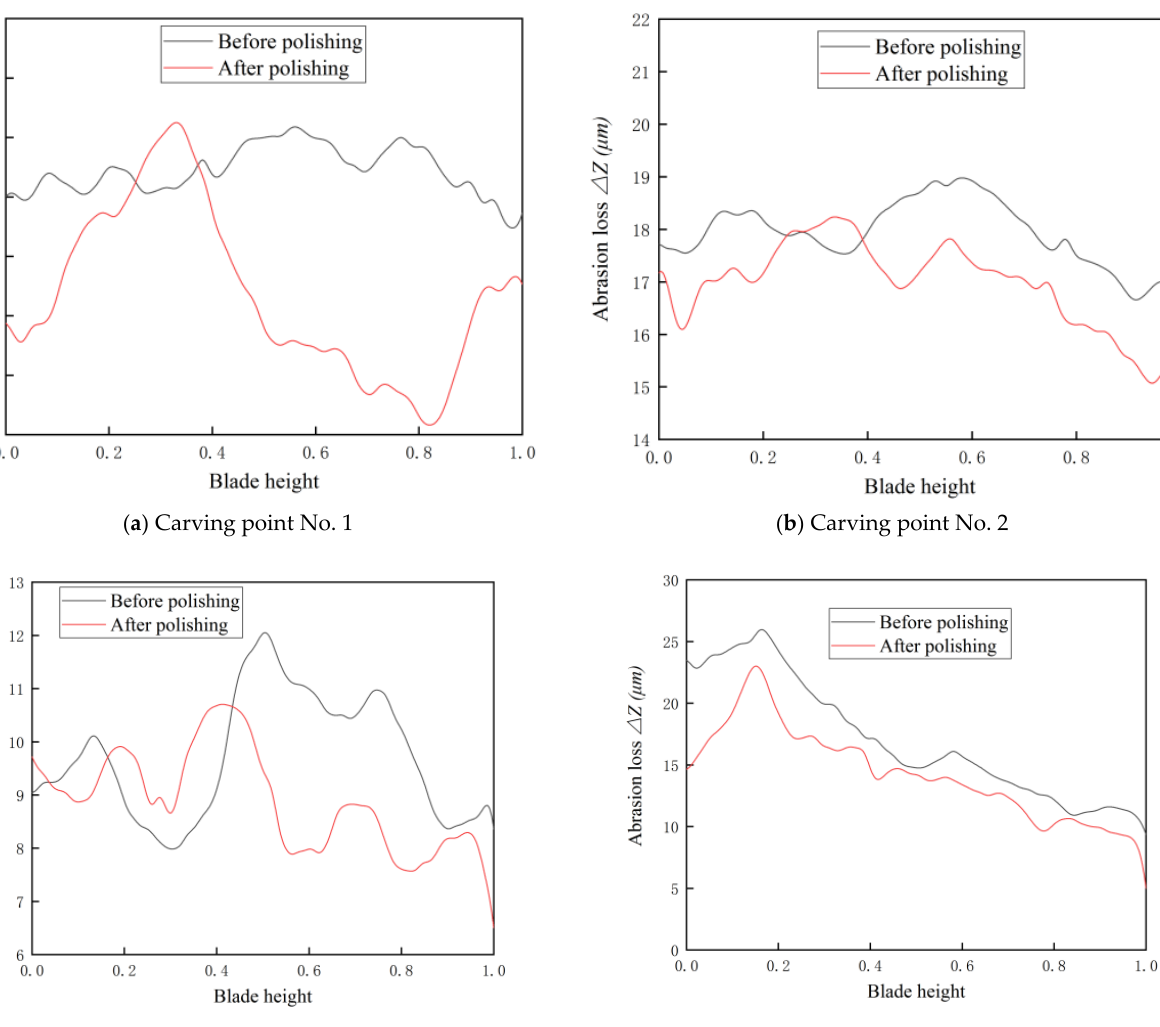
Figure 13. ( a – d ) Wear amount at different scoring points ( P = 30.9 MW).